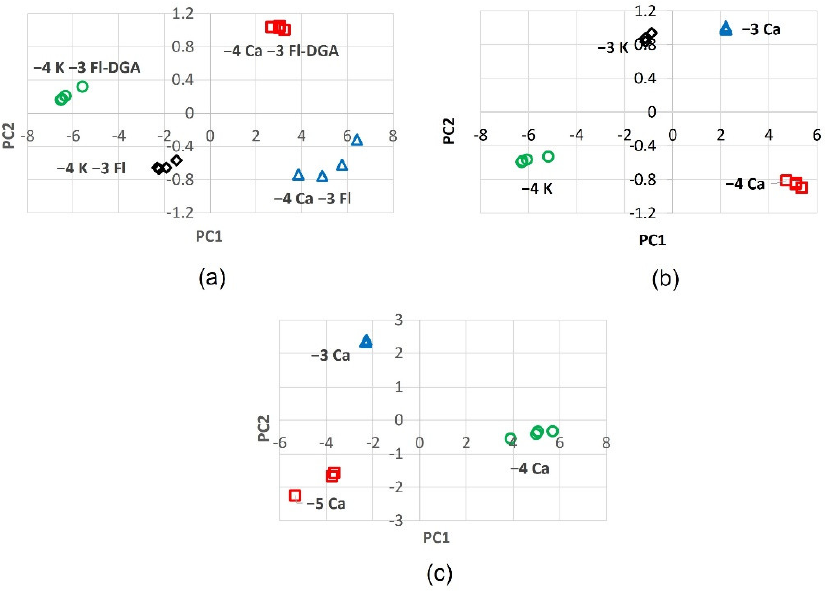
Figure 8. Score plots; ( a ) 0.1 mM K + and 0.1 mM Ca 2+ in 1 mM 1 , ( b ) 0.1 mM K + , 0.1 mM Ca 2+ , 1 mM K + , 1 mM Ca 2+ in 1 mM 1 , and ( c ) 0.01, 0.1 and 1 mM Ca 2+ in 1 mM 1 .